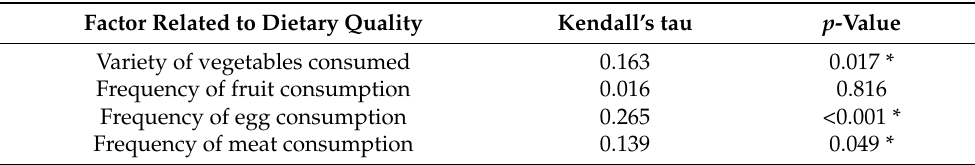
Table 3. Correlation of milk consumption with other dietary variables based on data from survey conducted between April and July 2019 in four villages in Kolar district,